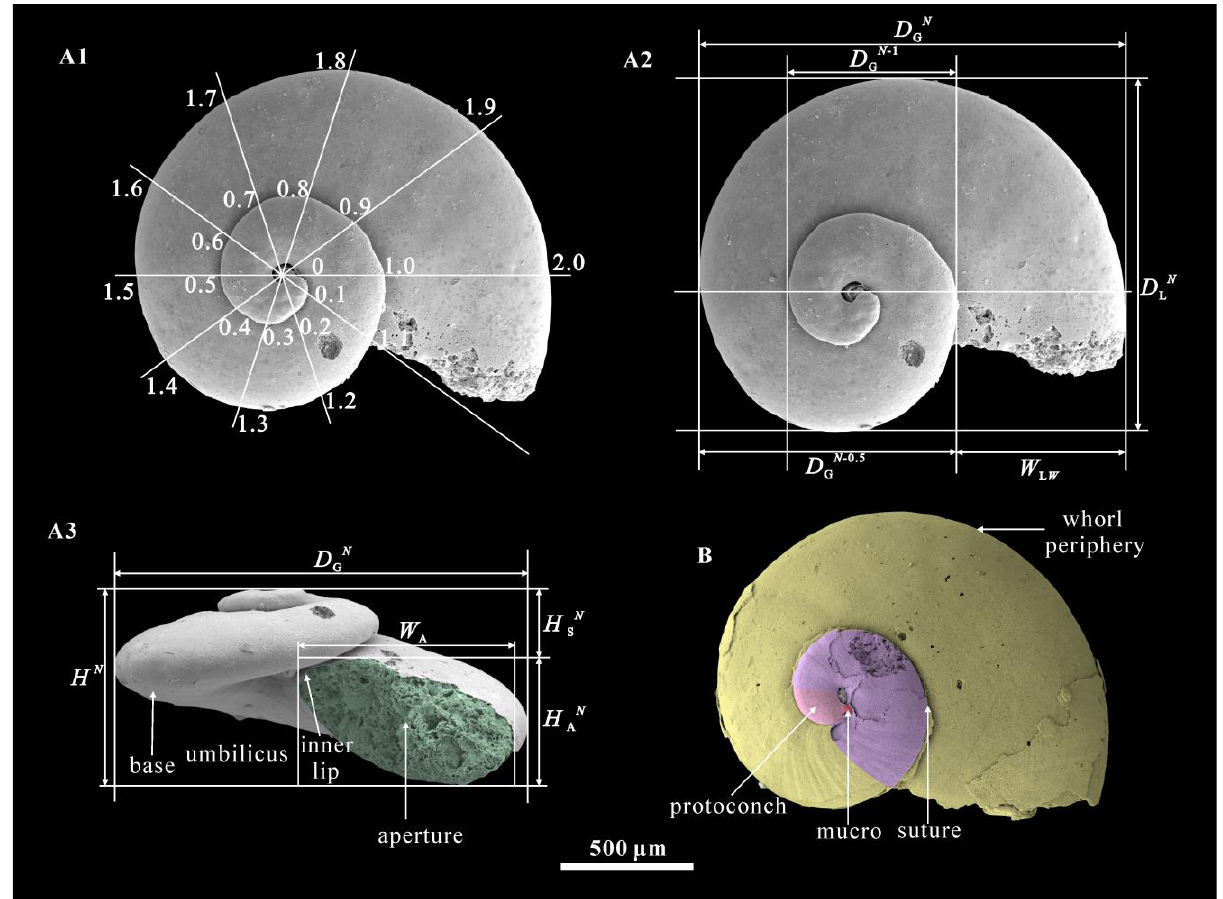
Figure 1. Scheme of measurements and anatomical terminology for Aldanella attleborensis . ( A ), internal molds, CUBar186-11; ( A1 ), the measurement scheme of number of whorls, ( A2 ), the measurement scheme of diameter, ( A3 ), the measurement scheme of height; ( B ), internal mold, CUBar250-2. Different color definitions: green — aperture; red — mucro; pink — protoconch; yellow — last whorl; pink and purple — spire. Symbols and abbreviations are as follows: D G N — greater shell diameter at the stage of N whorls; D L N — lesser shell diameter at the stage of N whorls; D G N − 0.5 — greater shell diameter at the stage of N- 0.5 whorls; D G N −1 — greater diameter at the stage of N -1; H N — shell height at the stage of N whorls. H S N — spire height at the stage of N whorls; H A N — height of aperture at the stage of N whorls; W A — aperture width; W LW — width of shell tube of the last whorl; K exp — ratio of greater shell diameter to the diameter of the previous whorl; K — ratio of shell height to greater diameter of shell; K iso — ratio of greater to lesser diameters of shell.